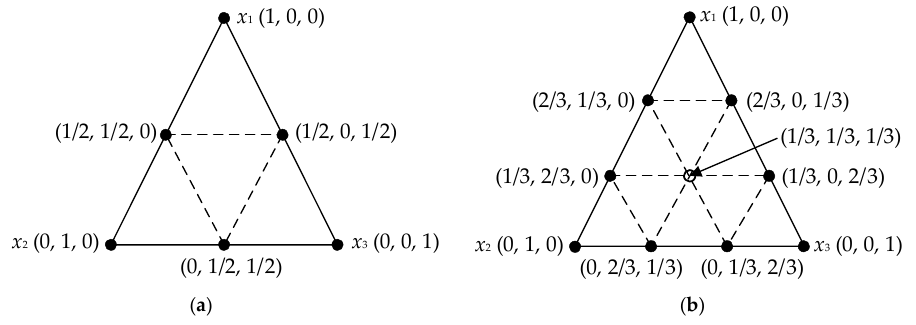
Figure 3. Three-ingredient simplex-lattice coordinate systems: ( a ) [3, 2] SLD; ( b ) [3, 3] SLD.